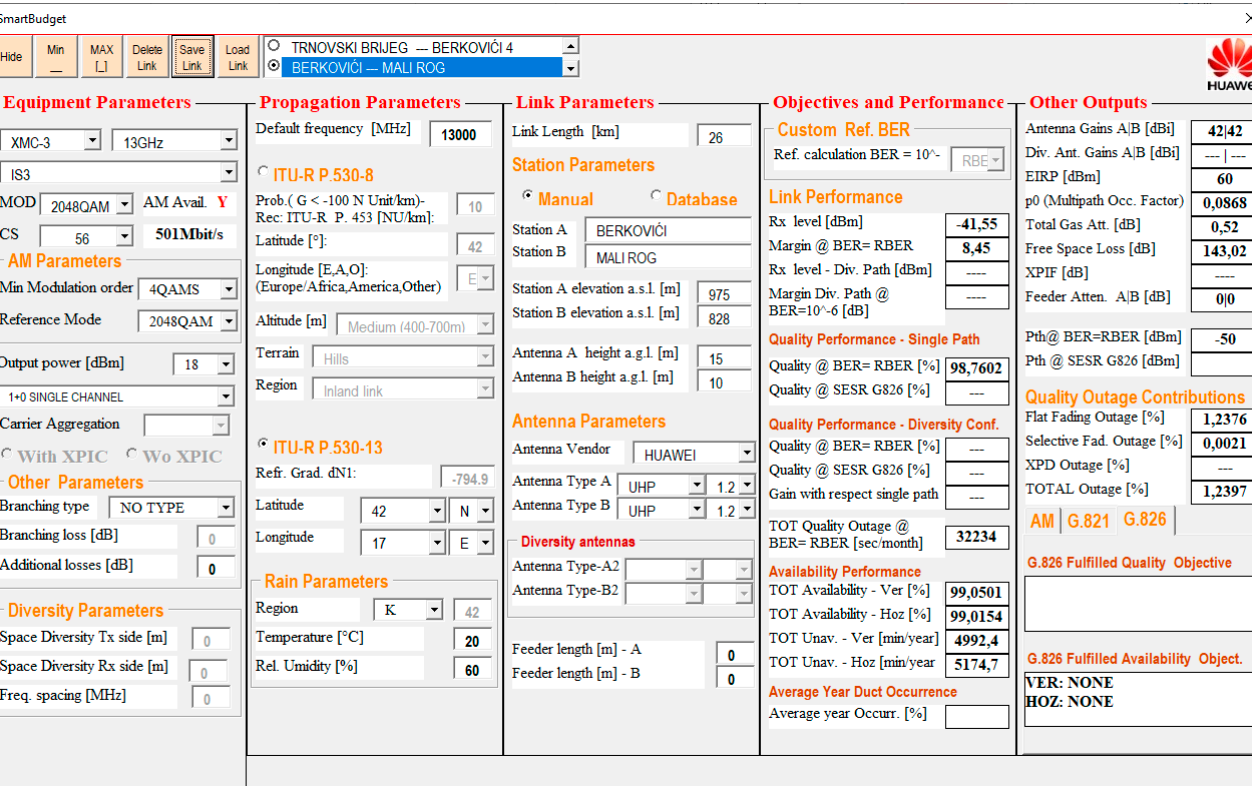
Figure 9. Prediction for the fourth RR section; 2048 QAM, 500 Mb/s.